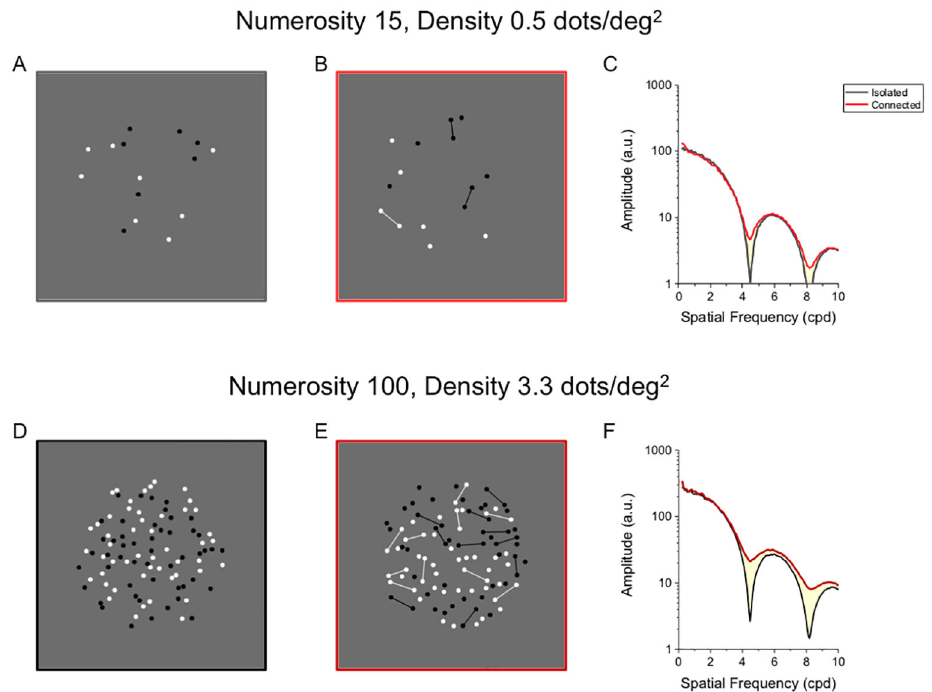
Figure 1. Illustration of stimuli and their Fourier transforms. Top row: Stimuli at low numerosity/density. (A) Sample patch containing only isolated dots (Numerosity = 15, Density = 0.5 dots/deg 2 ) (B) Stimulus of same numerosity but with 6 dots (40%) connected by thin lines. (C) Radial Fourier Spectra of the two patches: isolated dots (black), connectors (red). Note that the connected patterns have more energy at relatively high spatial frequencies, 4-6 c/deg. Bottom row (D-F): Stimuli at high numerosity/density (Numerosity = 100, Density = 3.3 dots/deg 2 ). Other conventions as